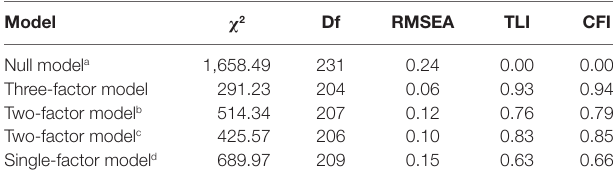
TaBle 2 | Confirmatory factor analyses results.